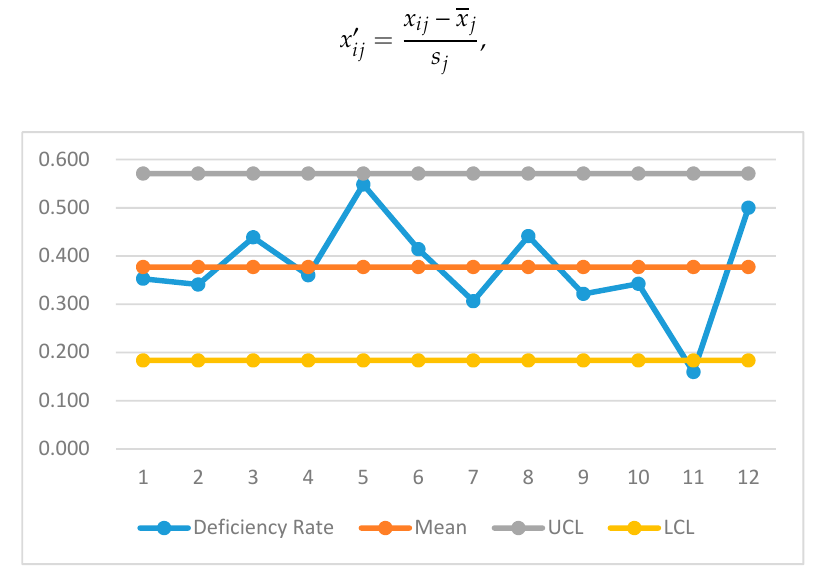
Figure 4. Control chart of deficiency 01 in 2015.